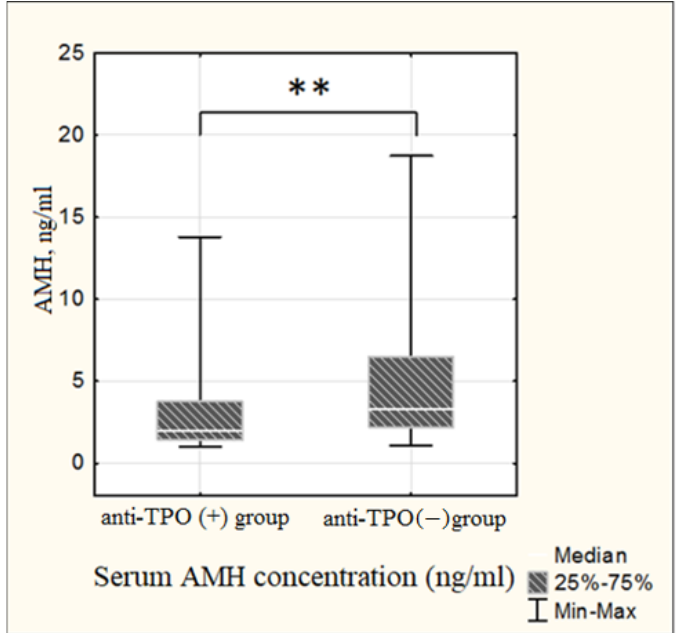
Figure 2. Comparative evaluation of serum AMH concentration in groups investigated. Mann– Whitney U-test, ** p < 0.01. AMH—anti-Müllerian hormone.